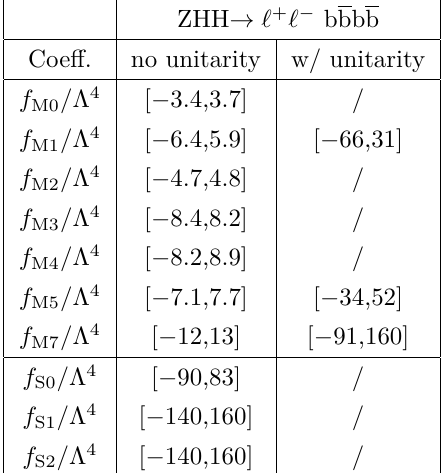
Table 7 . Constraints obtained with ZHH when applying or not unitarity constraints, in a projection with full HL-LHC luminosity. All entries represent 95% CL lower and upper limits in units of TeV − 4 . Bars represent processes for which there is no sensitivity to the corresponding operator, or cases where the theoretical unitarity bound is more stringent than the experimental one for all m cut-off